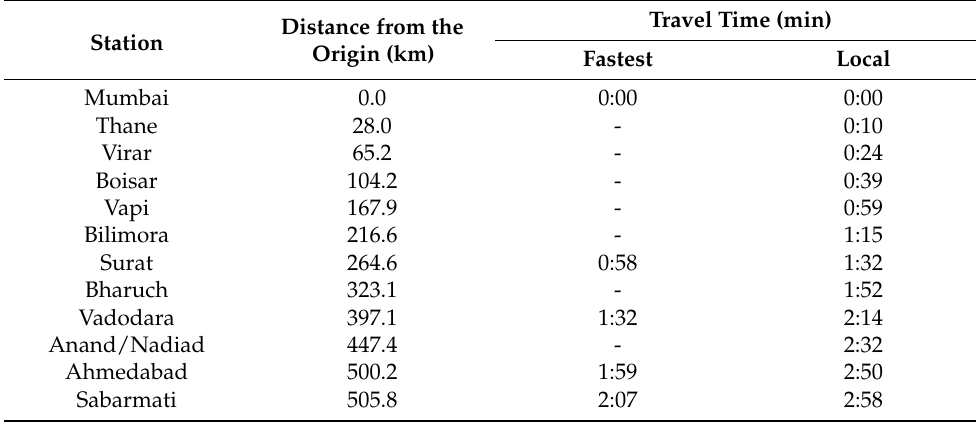
Table 5. Train operation plan for the MAHSR